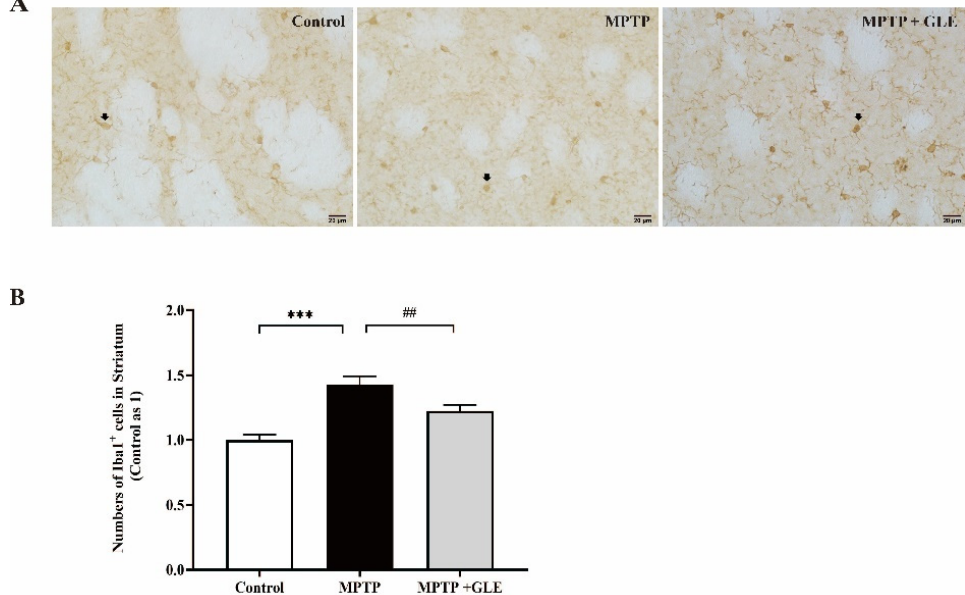
Figure 2. Effect of GLE on the expression of Iba1 in striatum of PD mice. ( A ) Representative immunohistochemistry images of Iba1 immunostaining in striatum, scale bar = 20 um. ( B ) The statistical results of Iba1-positive cells in the striatum area of each group. ***: p < 0.001, Control group vs. MPTP group; ##: p < 0.01, MPTP group vs. MPTP + GLE group. Data are presented as mean ± SEM. Each group n /N ≥ 20 images/5 mice. The arrows stand for Iba1+ cells.